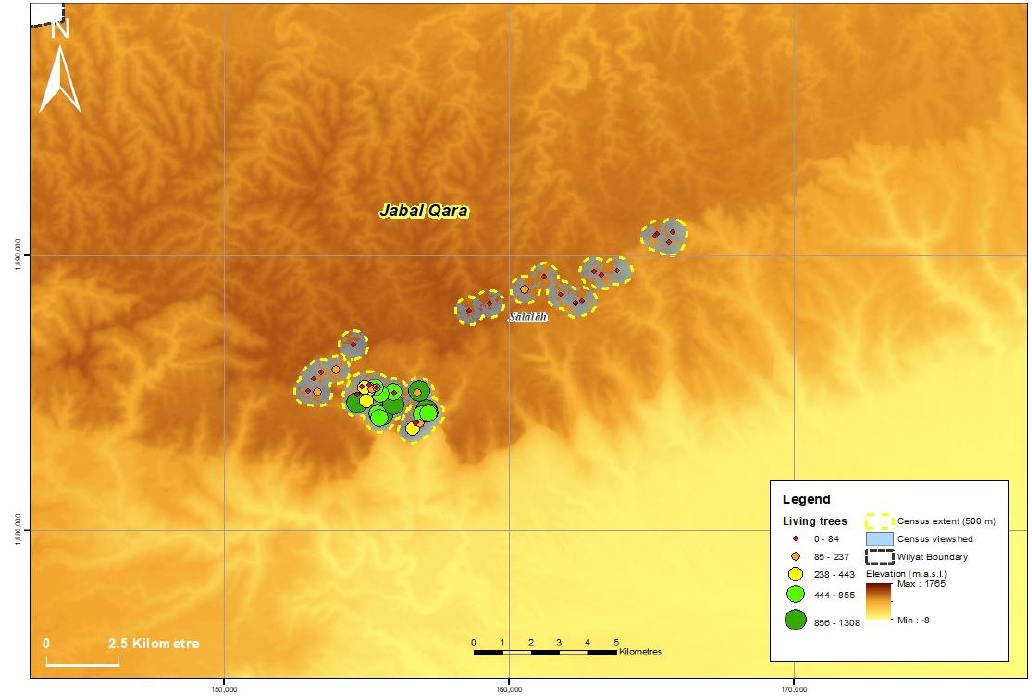
Forests 2019 , 10 , x FOR PEER REVIEW Figure 3. Distribution of census survey points, viewshed areas (depicted in blue within the dashed yellow lines), and total tree numbers on Jabal al Qara, southern Oman, January 2018.